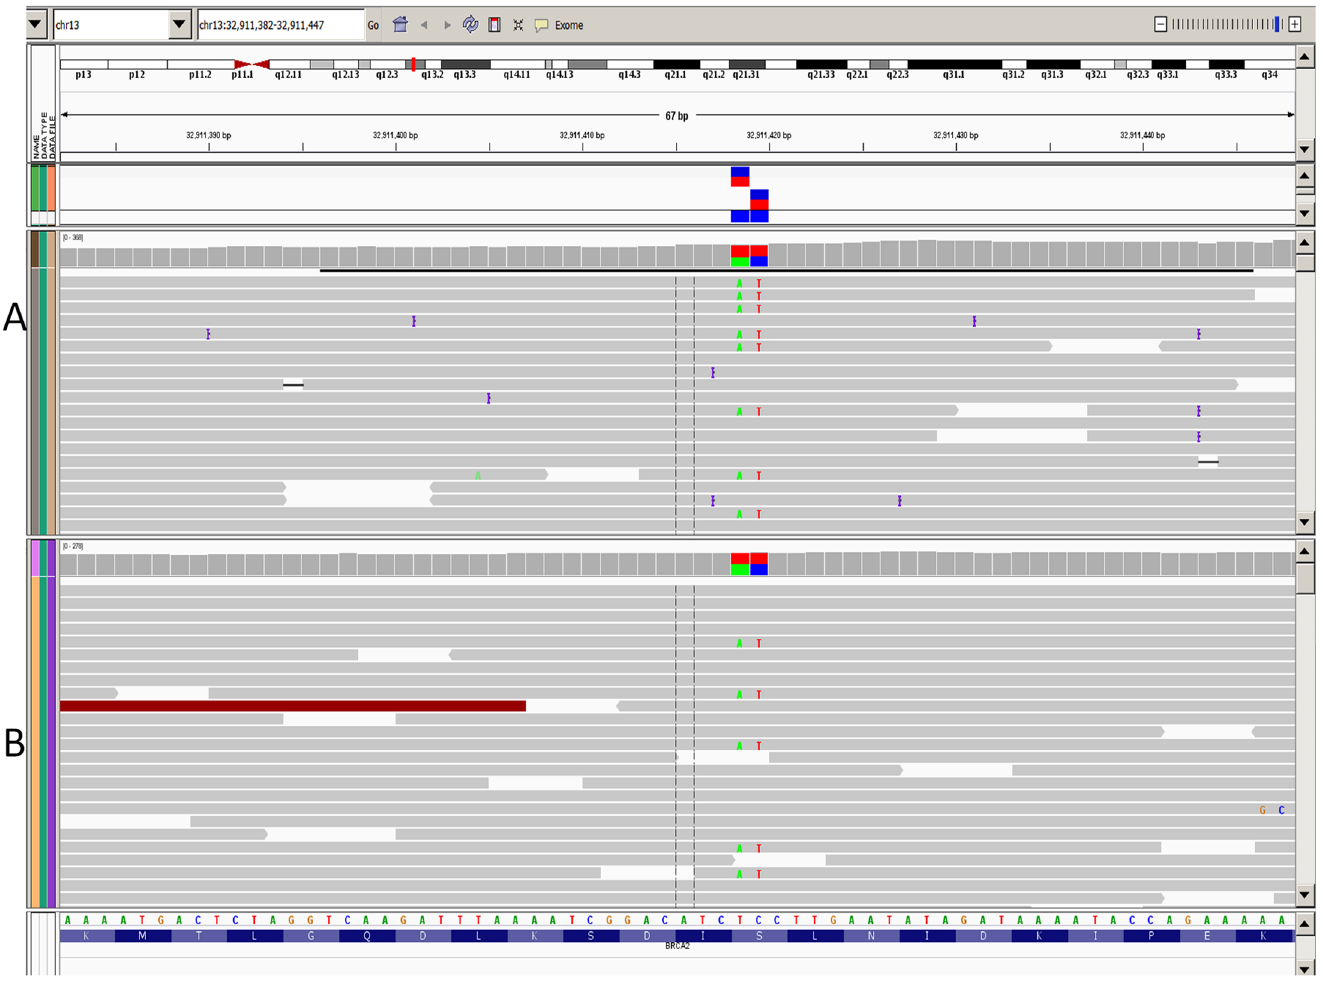
Fig 4. Determination of cis vs trans orientation using next-generation sequencing (NGS). The Integrative Genomics Viewer (IGV) graphic report is from a patient with 2 adjacent variants on a single DNA molecule visualized with NGS on the MiSeq/QSAP platform. The cis orientation is clearly visible, as each strand contains either both or neither of the